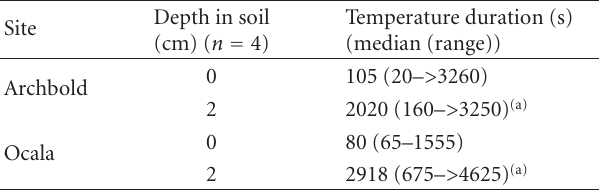
Table 4: Temperature durations of copper-constantan thermo- couples placed at the soil surface and at 2cm depth in the soil. Temperatures were quantified during prescribed fires conducted during May 1993 at Ocala National Forest and Archbold Biological Station, Florida. Temperature duration was defined as length of time that (0.75 × maximum thermocouple temperature) was maintained or exceeded.